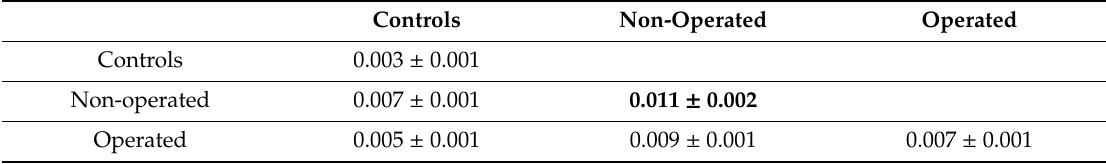
Table 4. Genetic distances within and among groups.